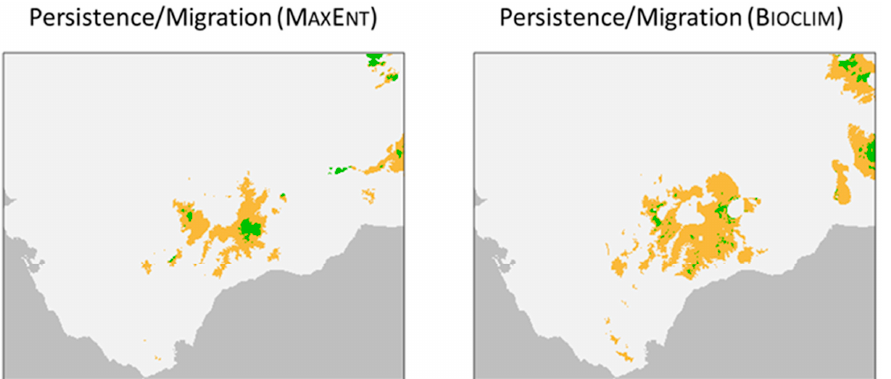
Figure 5. Persistence versus migration. Distributions projected using M AX E NT and B IOCLIM in the Baetic System. Persistence (brown) is shown in those areas where the suitability of the habitat is greater for the “mature” group than it is for the “sapling” group, while the migration areas (light green) are those where the suitability of the habitat is greater for the “sapling” group than it is for the “mature” group.